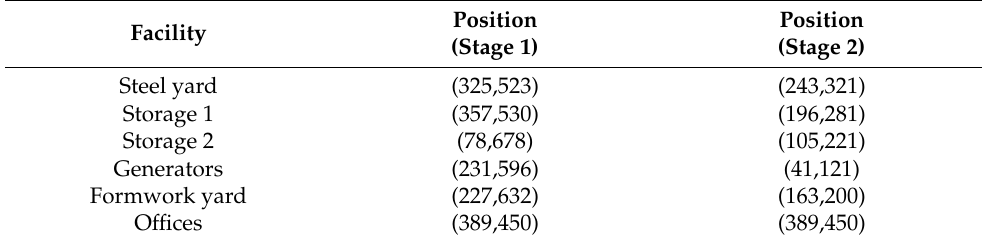
Table 2. Site layout for two stages of the construction